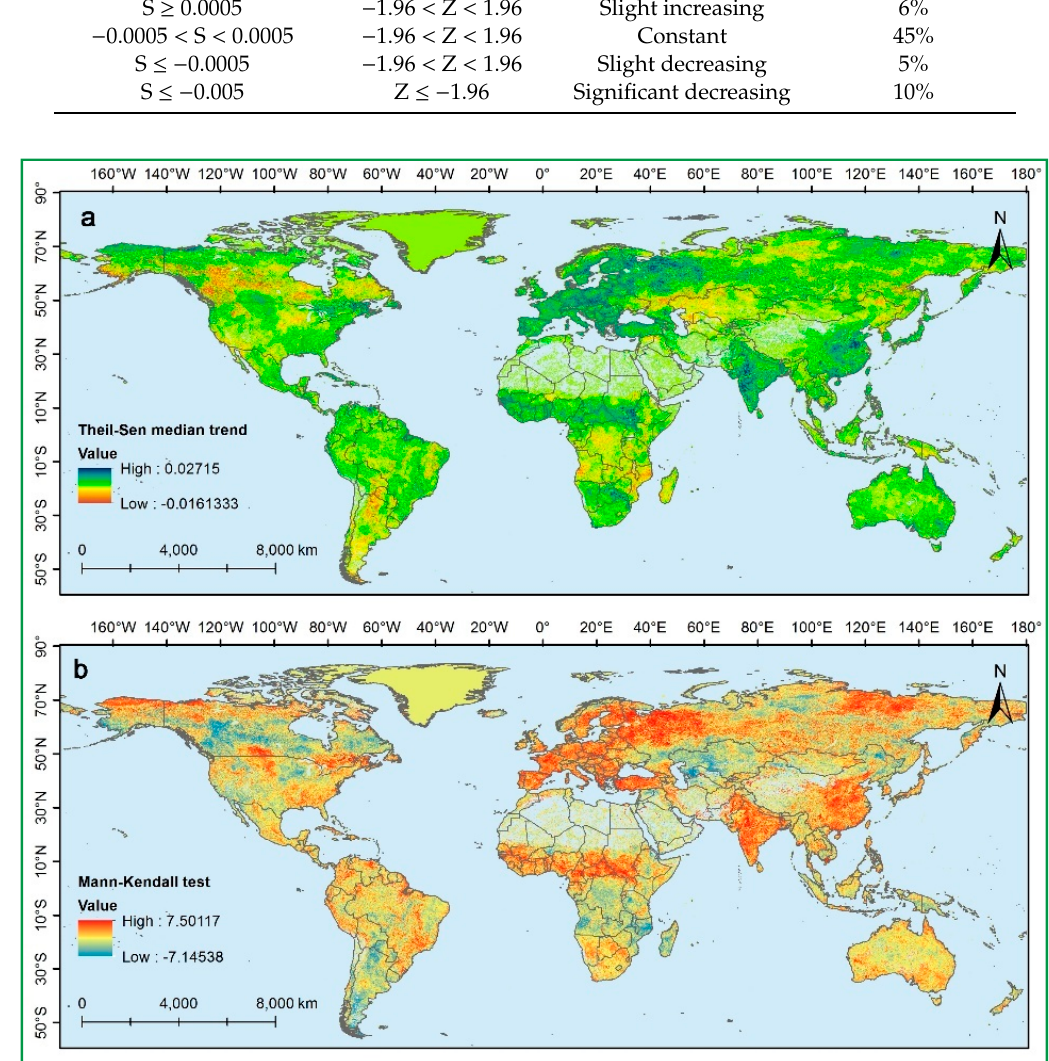
Figure 3. Spatial distribution of the S NDVI ( a ) and Z value ( b ). Table 2. The statistics of NDVI trends.